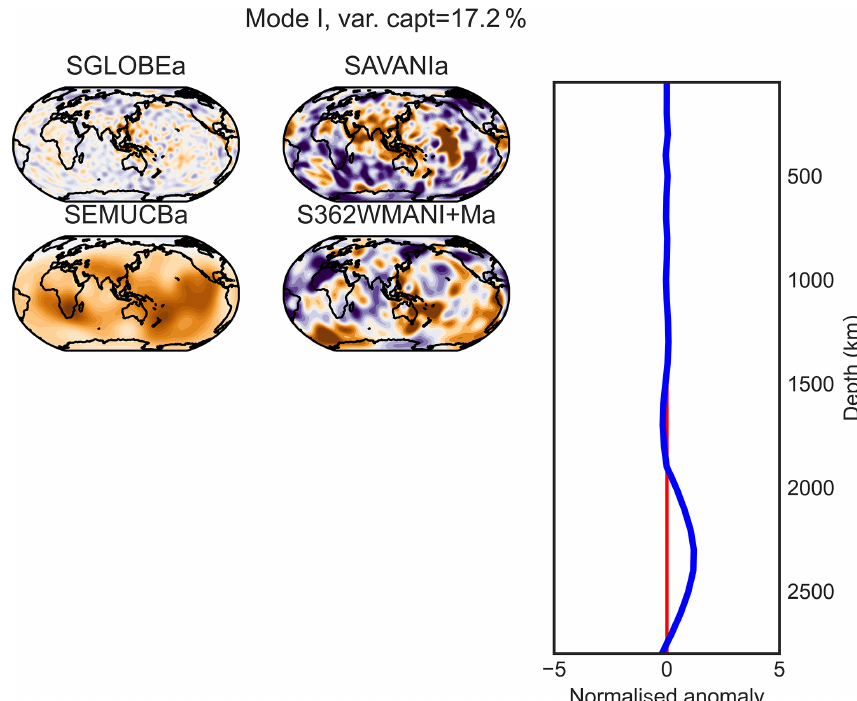
Figure E9. PC I (maximum at 2300km of depth) of the combined analysis of the anisotropic parts of the models.